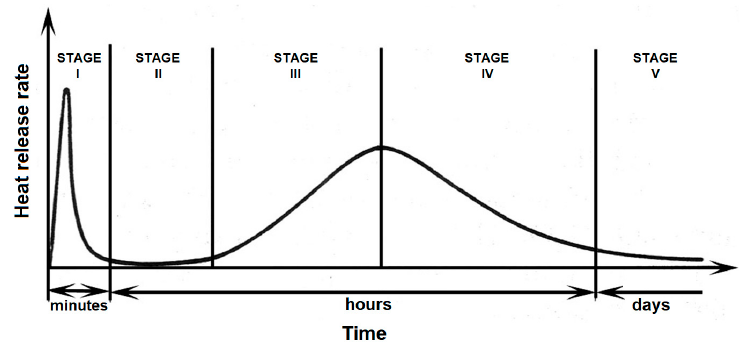
Figure 2. Microcalorimetric curve of the cement hydration process.